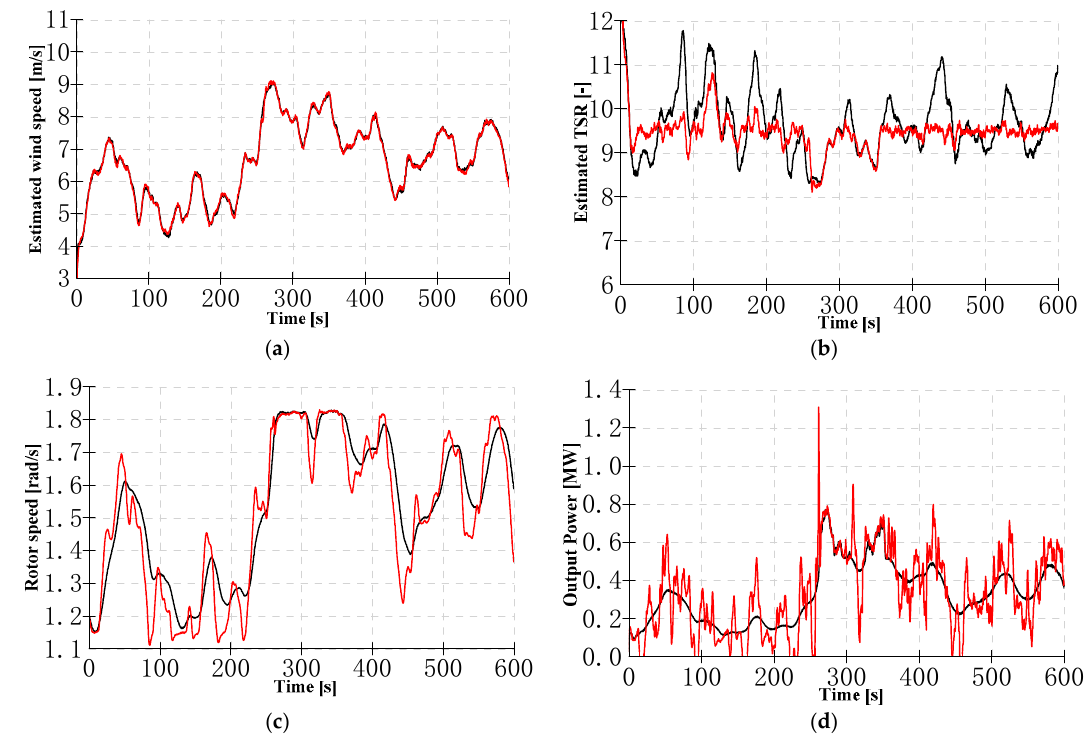
Figure 6. Simulation results under Case 2 with mean wind speed of 6 m/s and TI of 0.269.